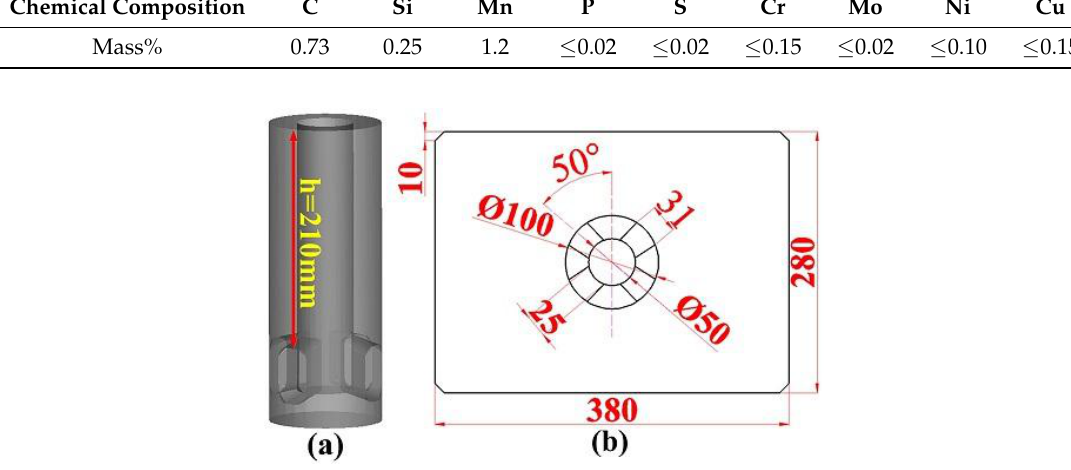
Table 1. Target chemical composition of U71Mn steel.